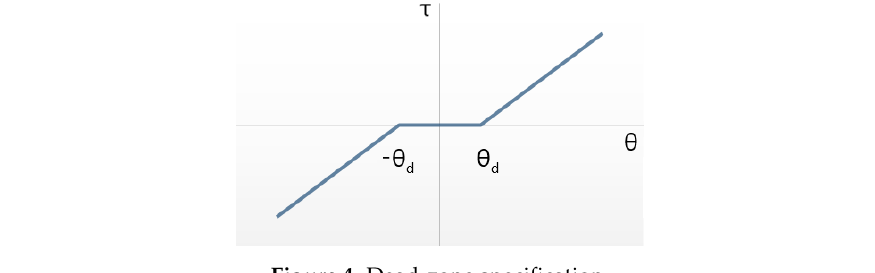
Figure 4. Dead-zone